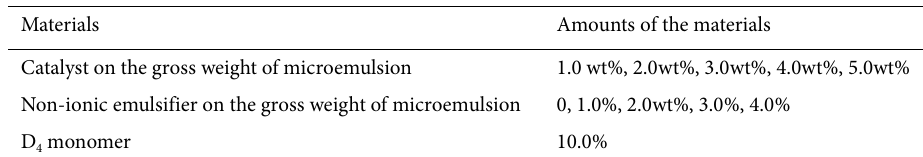
231 Nanochem Res 1(2): 229-236, Summer and Autumn 2016